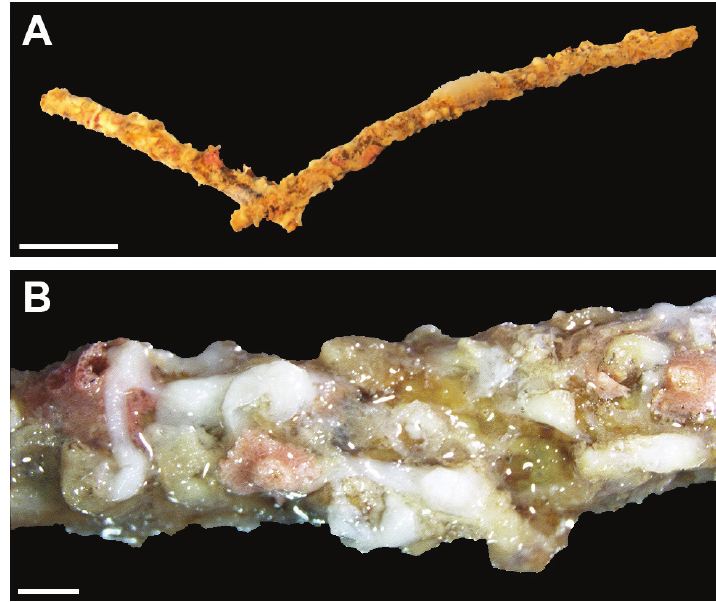
Figure 2. Altumia delicata gen. n. sp. n. holotype ZMTAU CO 37427. A Colony growing over a branch of a black coral B close up of holotype. Scale 10 mm at A , 1 mm at B